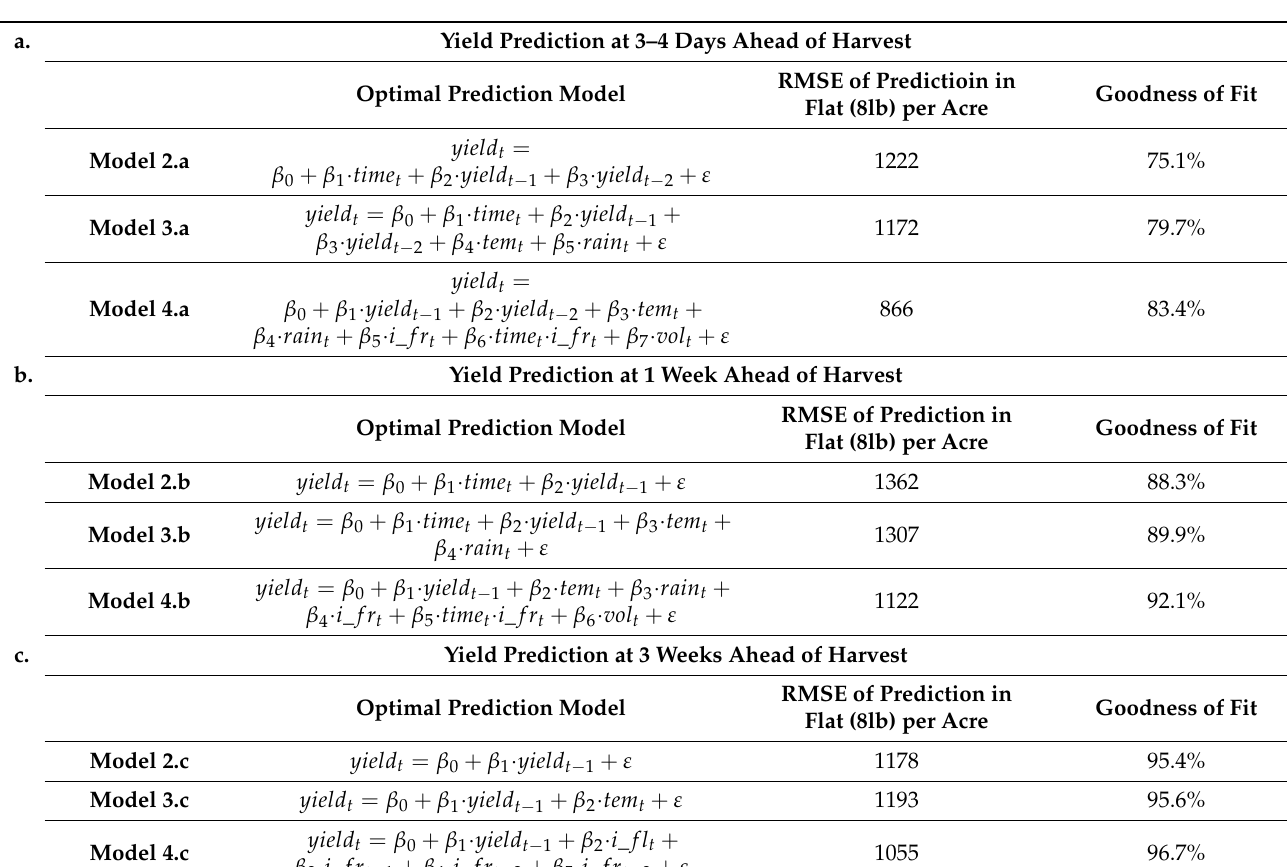
Table 4. Yield Prediction Models and their